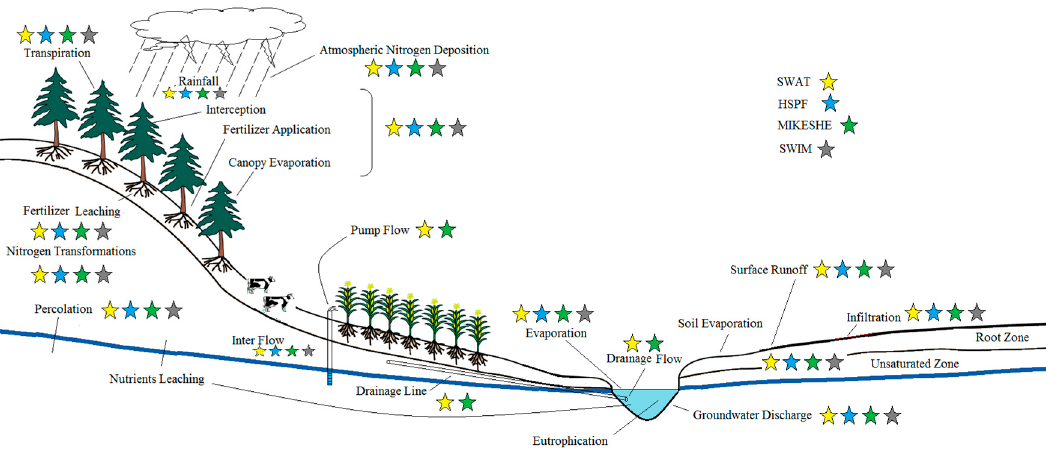
Figure 1. Ability of selected modelling tools to simulate the desired hydrological processes in north-eastern Germany lowland catchment based on literature [40].